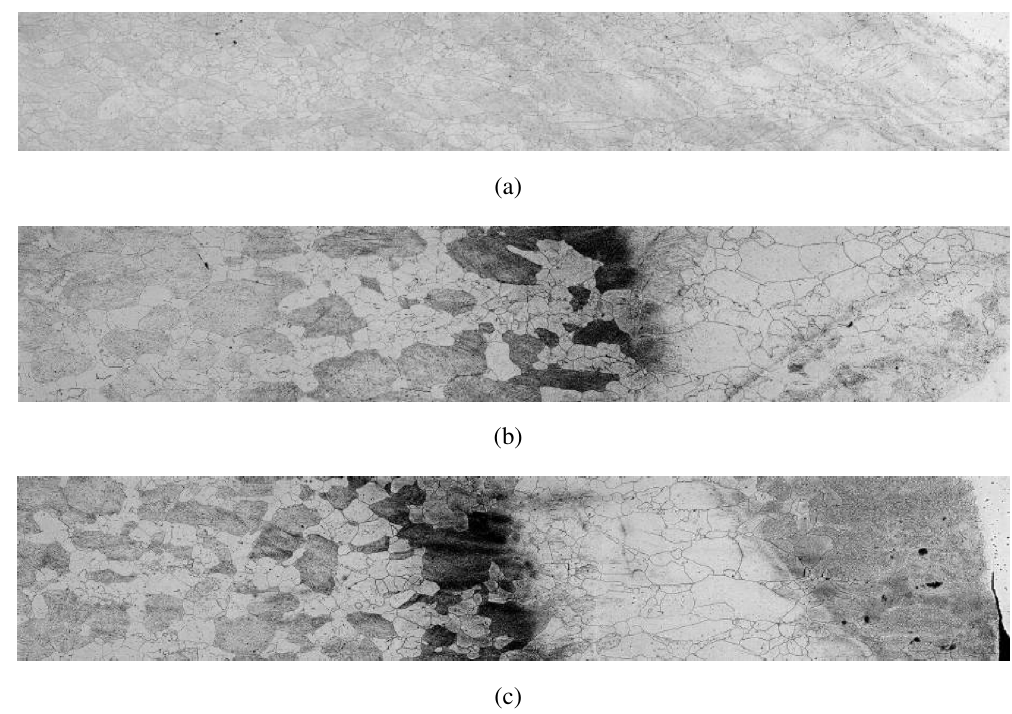
Figure 1. Examples of mosaics manually built for the steel microstructures